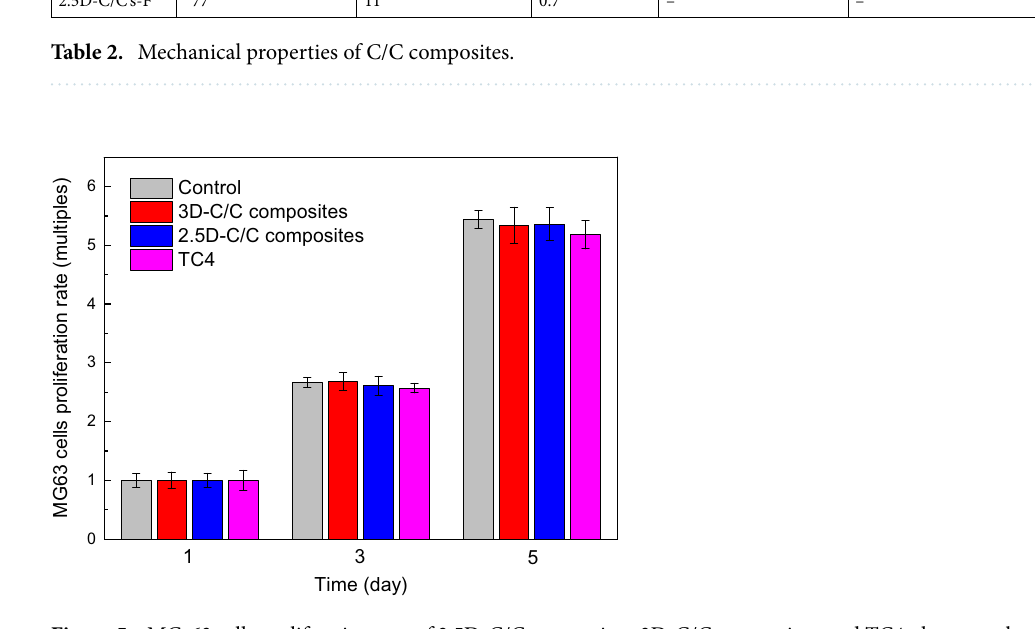
Figure 5. MG-63 cells proliferation rate of 2.5D-C/C composites, 3D-C/C composites, and TC4, the control group is listed as